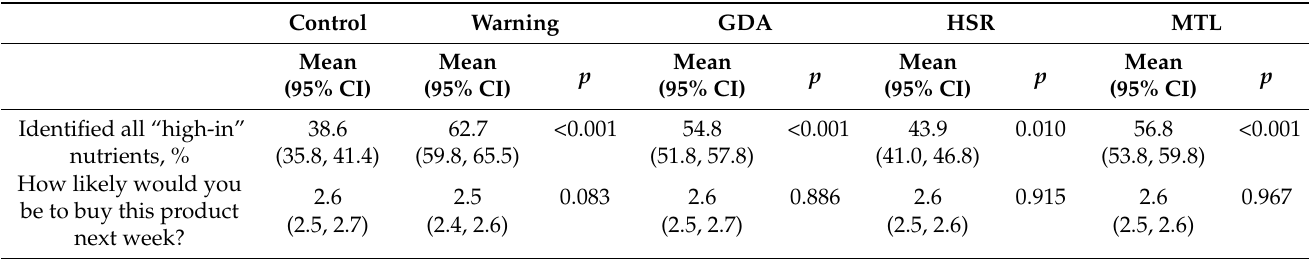
Table A8. Sensitivity results for the primary outcomes excluding participants who had been inter- viewed by one of the six interviewers with the highest or lowest three outcome means in their groups of participants ( n = 354 and 303 excluded participants, or 1770 and 1515 observations, for identifying all excess nutrients and purchase intentions,